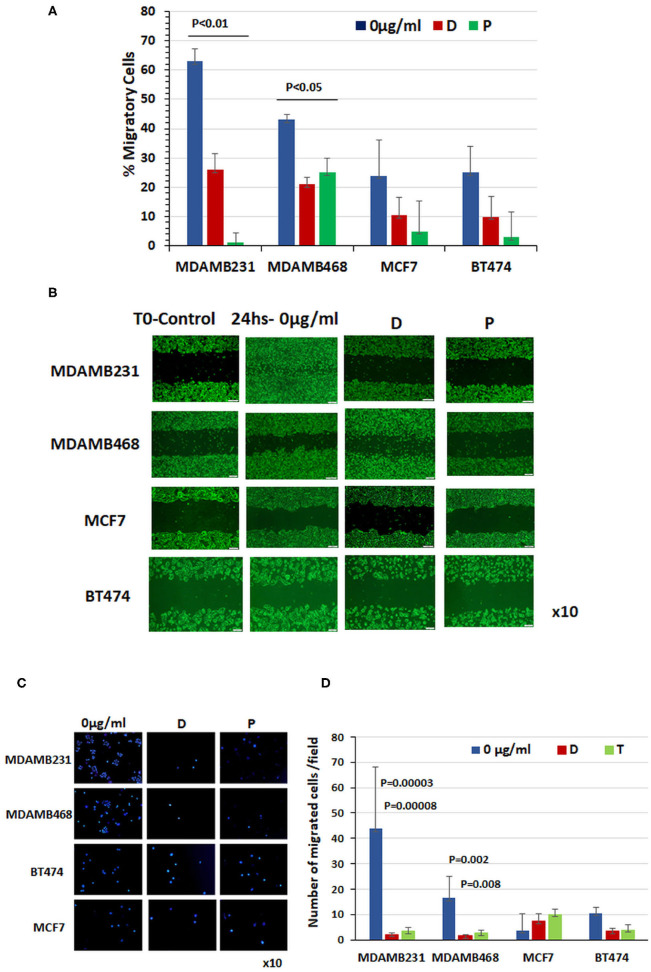
Chemotherapy prevented migration of triple-negative breast cancer cells. (A) Percentage of cell migration determined with monolayer gap closure assays. (B) Representative snapshots taken under a light microscope immediately after wound generation (10 ×, scale bar = 200 μm) and 24 h after addition of chemotherapy drugs to cultures. (C) Representative photographs of DAPI-stained cells obtained under a light microscope (10 ×). Note the cell migration through a transwell after 24 h treatment with doxorubicin or paclitaxel compared to untreated control cells. (D) Quantitation of migrated cells in each cell line at baseline and 24 h after administration of doxorubicin and paclitaxel (results of three different experiments ± SE).